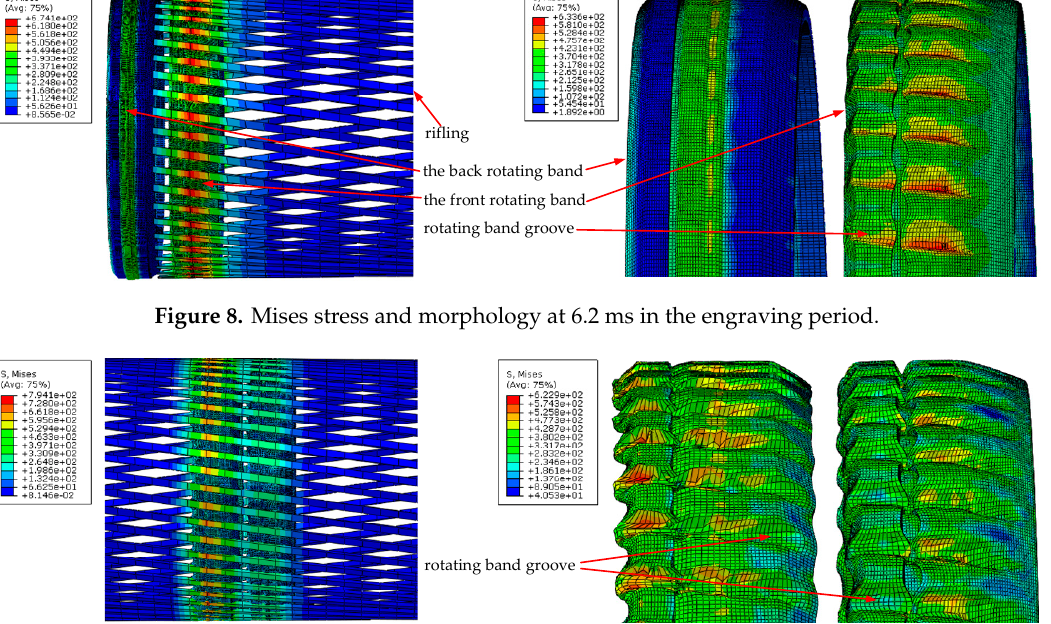
Figure 9. Mises stress and morphology at 9.5 ms in the translation-rotation period.